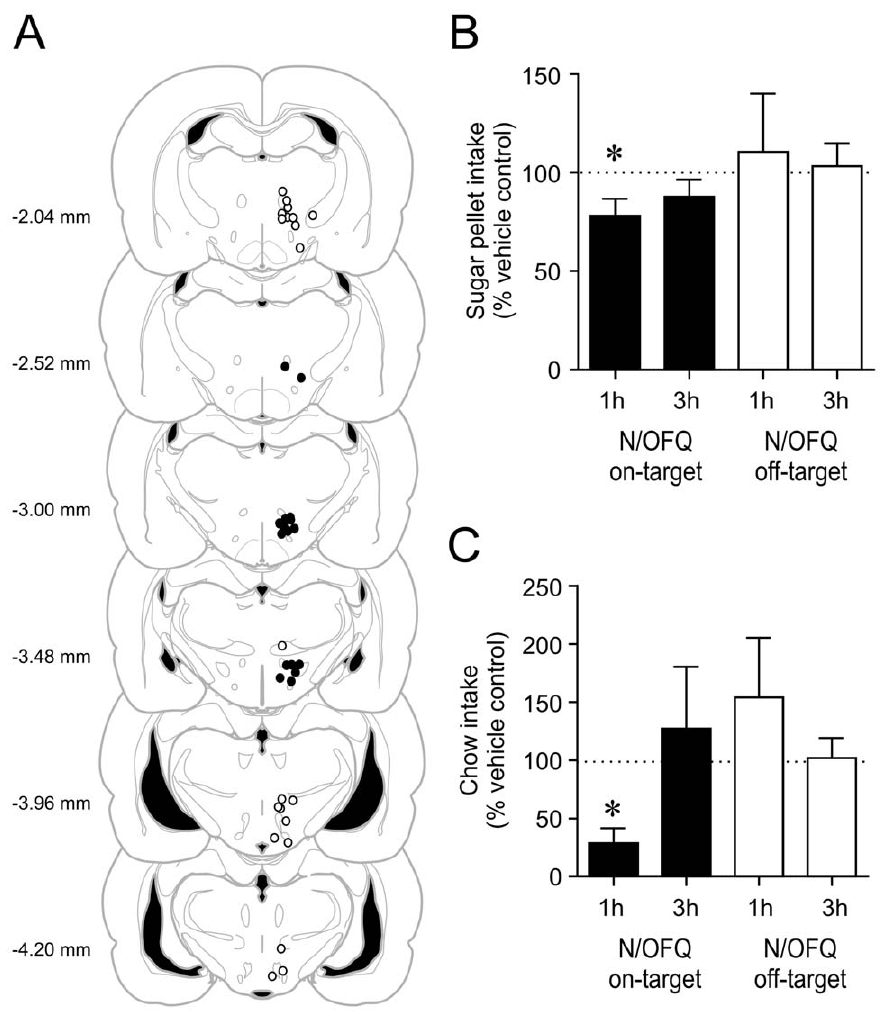
Figure 1. Intra-LH/PFA N/OFQ injection decreases palatable food intake. A : Coronal brain maps depicting the location of injections. Each circle represents a rat used for the analysis. Filled and open circles were categorized as on- or off-target, respectively, relative to the orexin/MCH field. Numbers on the left of each map indicate the posterior distance from the bregma based on the Rat Brain Atlas by Paxinos and Watson [57]. The brain maps were modified from the images in the Atlas. B : N/OFQ significantly reduced the sugar pellet intake during the first hour (1 h) following an injection into the LH/PFA (on-target) but not the 3h-total intake post-injection (filled bars). In contrast, N/OFQ injections outside of the LH/PFA (off- target) did not affect the sugar pellet consumption (open bars). C : N/OFQ significantly reduced chow intake during the first hour (1 h) following an injection into the LH/PFA (on-target) but not the 3h-total intake (filled bars). This effect was not seen when the injection was off-target. * p , 0.05.